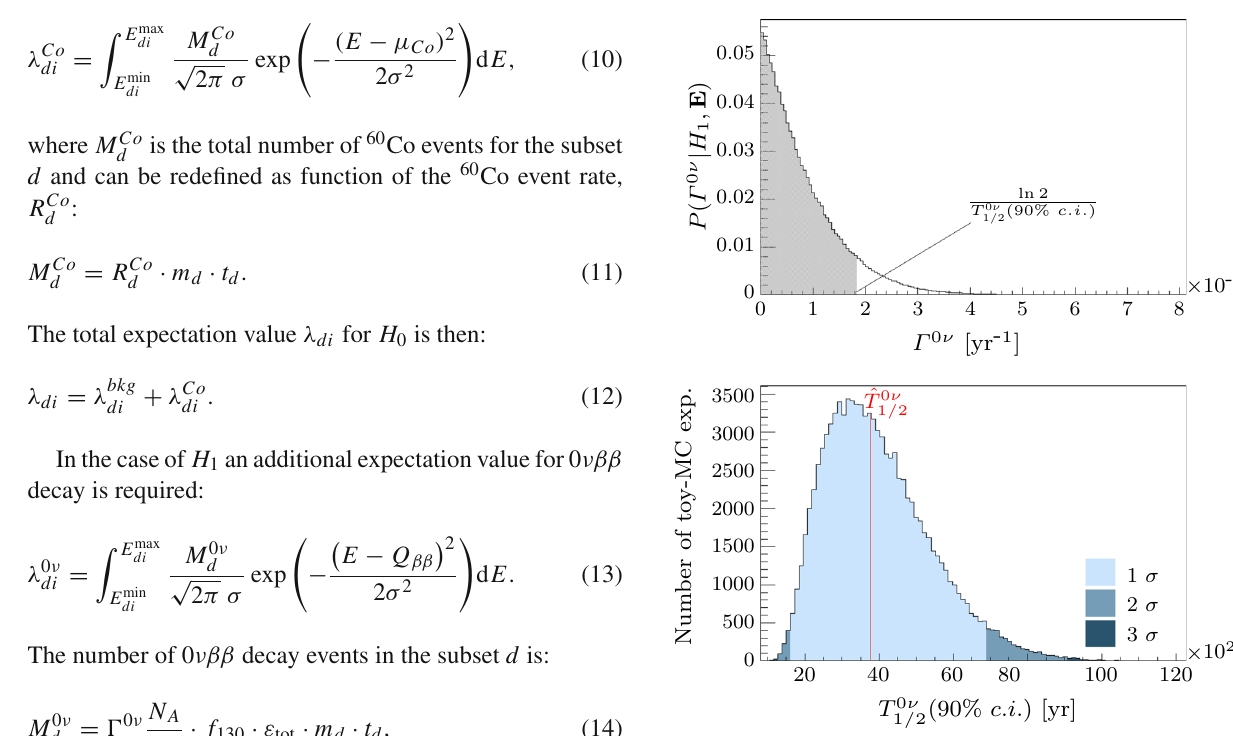
Fig. 1 Top Marginalized probability distribution for (cid:5) 0 ν relative to one toy-MC experiment. The 90%CI limit on T 0 ν is indicated. Bottom 1 / 2 for 10 5 toy-MC experiments. distribution of the 90%CI limits on T 0 ν 1 / 2 The red vertical line corresponds to the median sensitivity, while the three colors depict the 1, 2 and 3 σ quantiles of the distribution. Both plots are obtained with 1year live time, a 10- 2 cts /( keV · kg · yr ) BI and 5keV energy